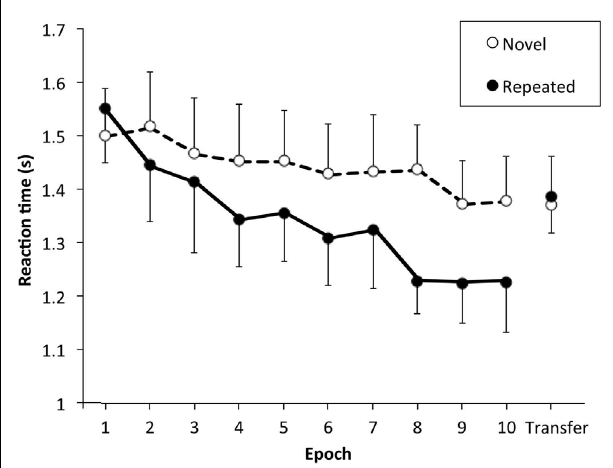
FIGURE 2 | Reaction time as a function of epoch in the stay condition of 3D stimulus shown as a representative. Two blocks are averaged into one epoch.The vertical axis indicates reaction time, and the horizontal axis indicates epoch. Data connected by lines show the results in the learning phase and the rightmost data show the results in the transfer phase.The open circle represents reaction time for the novel configurations, and the solid circle represents that for the repeated configurations. Error bars represent standard error across participants.